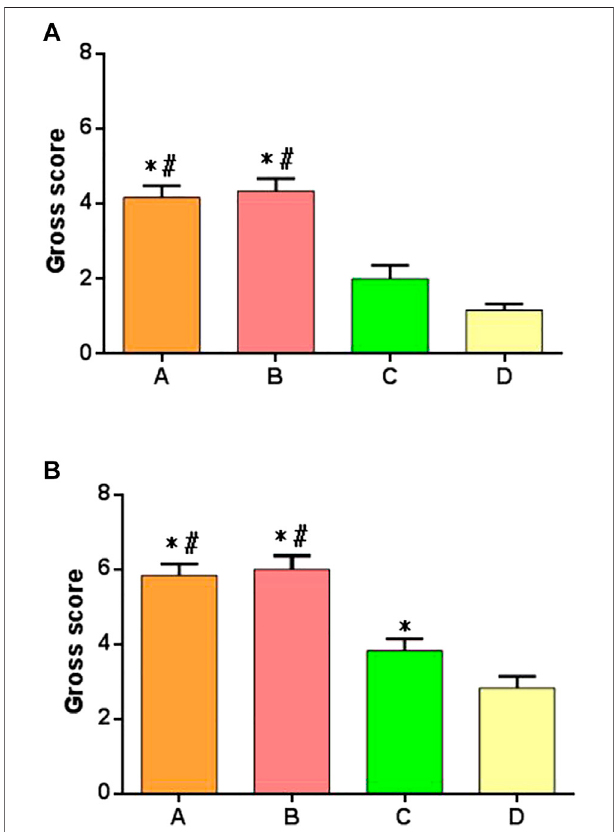
FIGURE 9 | Gross joint scores of postoperative specimens in each group. (A) Specimen score of each group at 6 weeks after surgery. (B) Specimen score of each group at 12 weeks after surgery. *: signi fi cant difference compared with group D; # : there was a signi fi cant difference compared with group C ( p <